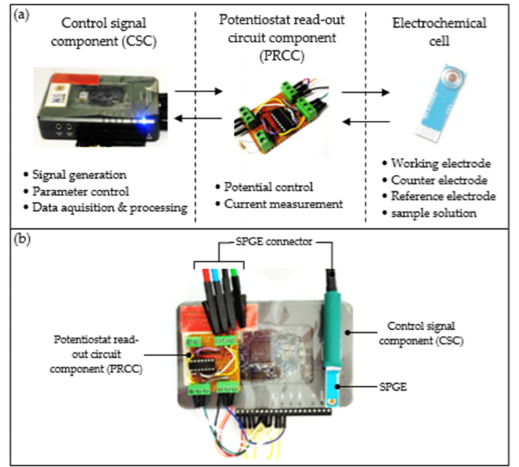
Figure 5. ( a ) The HMstat consists of Control Signal Component (CSC) and Potentiostat Read-out Circuit Component (PRCC) connected to the electrochemical cell (consisting of Screen Printed Electrode Gold (SPGE) and ( b ) overall connection of HMstat